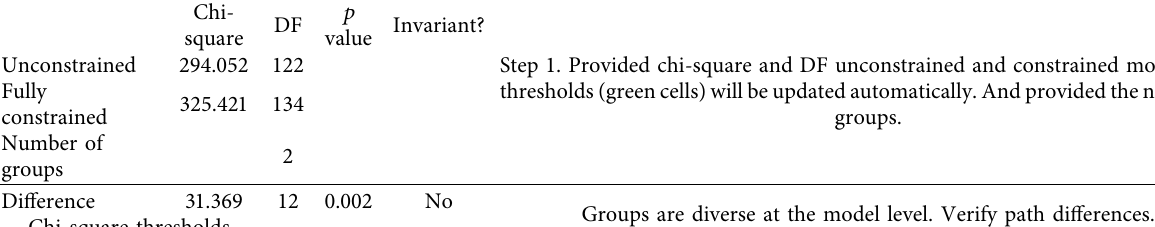
Table 11: Analysis of the moderator for latent